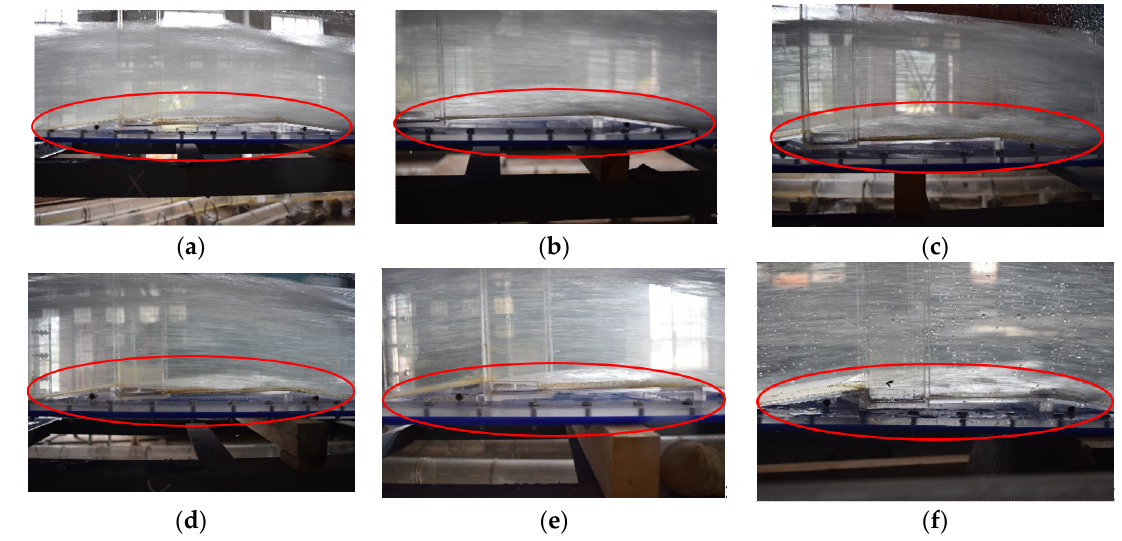
Figure 9. Flow pattern of parts of aerators 1–12: ( a ) aerator 2; ( b ) aerator 4; ( c ) aerator 6; ( d ) aerator 8; ( e ) aerator 10; ( f ) aerator 12.